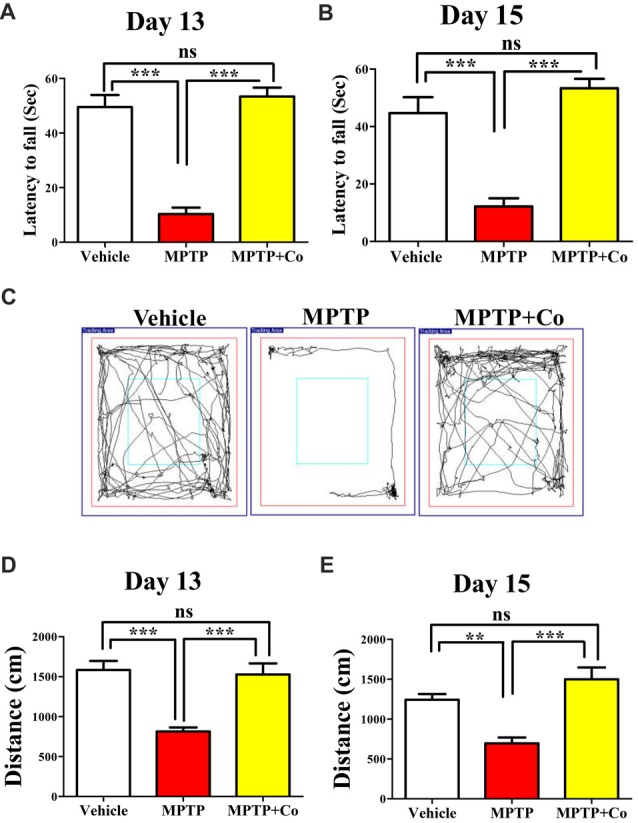
XCT 790 ameliorates MPTP-induced behavioral impairments. Latency to fall for various cohorts such as vehicle, MPTP and MPTP+Co on both day 13 (A) and 15 (B) were monitored using Rotarod test (n = 8 animals per cohort). Statistical analysis was performed using one-way ANOVA and the post hoc Bonferroni test. Error bars, mean ± SEM. ns-non significant, ***P < 0.001. (C) Representative trajectory maps were indicated for all the mentioned cohorts. (D,E) Plots indicating the peripheral distance traveled by mice were assessed through Open Field test on both day 13 (D) and 15 (E; n = 8 animals per cohort). Statistical analysis was performed using one-way ANOVA and the post hoc Bonferroni test. Error bars, mean ± SEM. ns-non significant, **P < 0.01, ***P < 0.001.